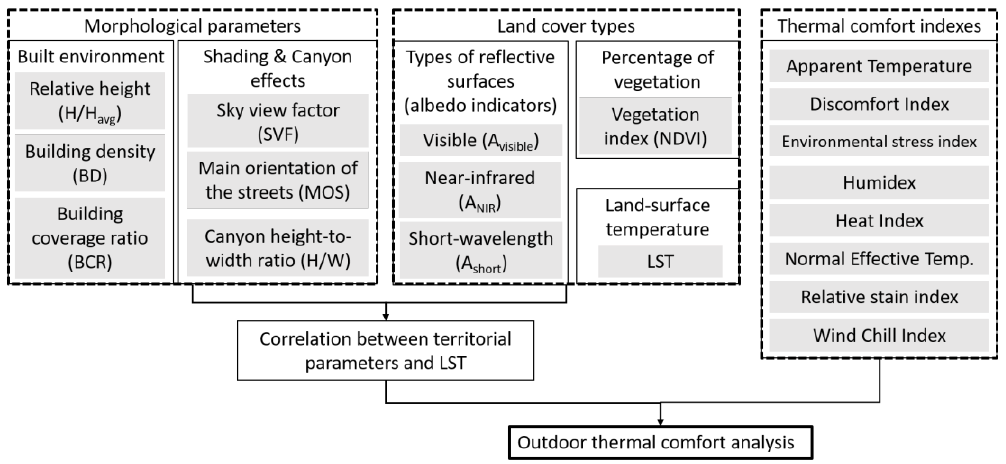
Figure 2. Methodological scheme of the outdoor thermal comfort analysis.